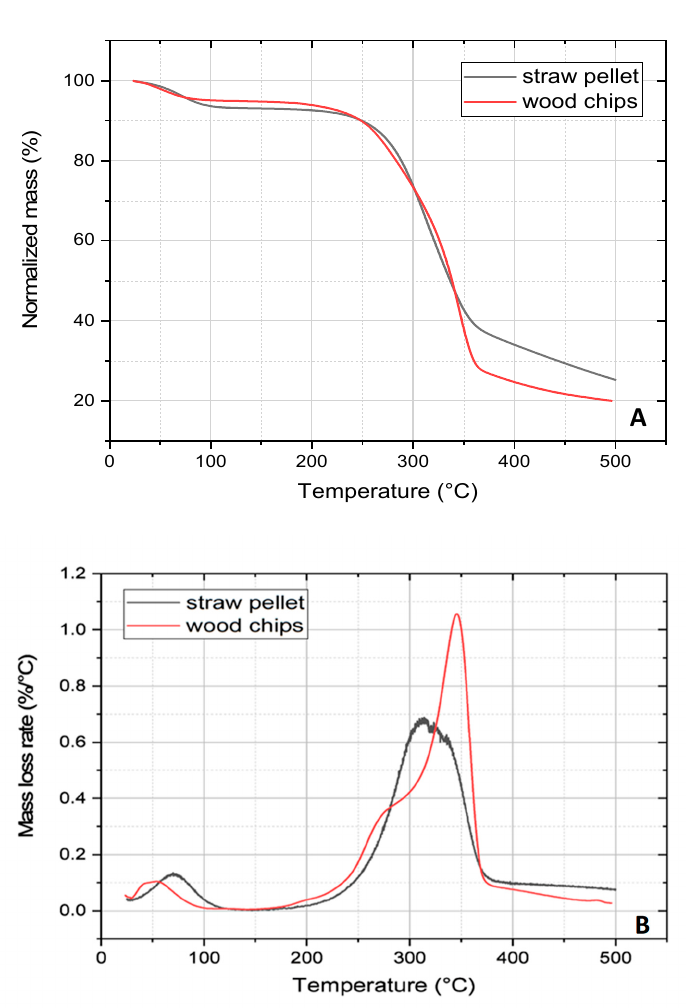
Figure 3. ( A ) Thermal analysis of the straw and wood samples; ( B ) derivative of mass loss in time for straw and wood samples obtained at 15 °C/min under a nitrogen atmosphere.